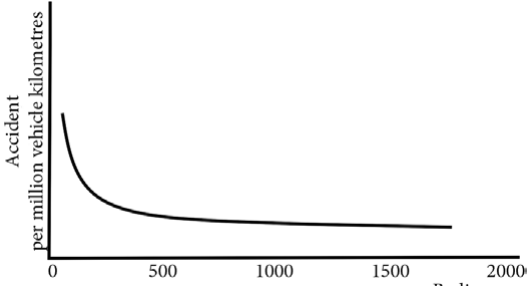
Fig. 1. Effect of horizontal curve radius on accident risk (PIARC